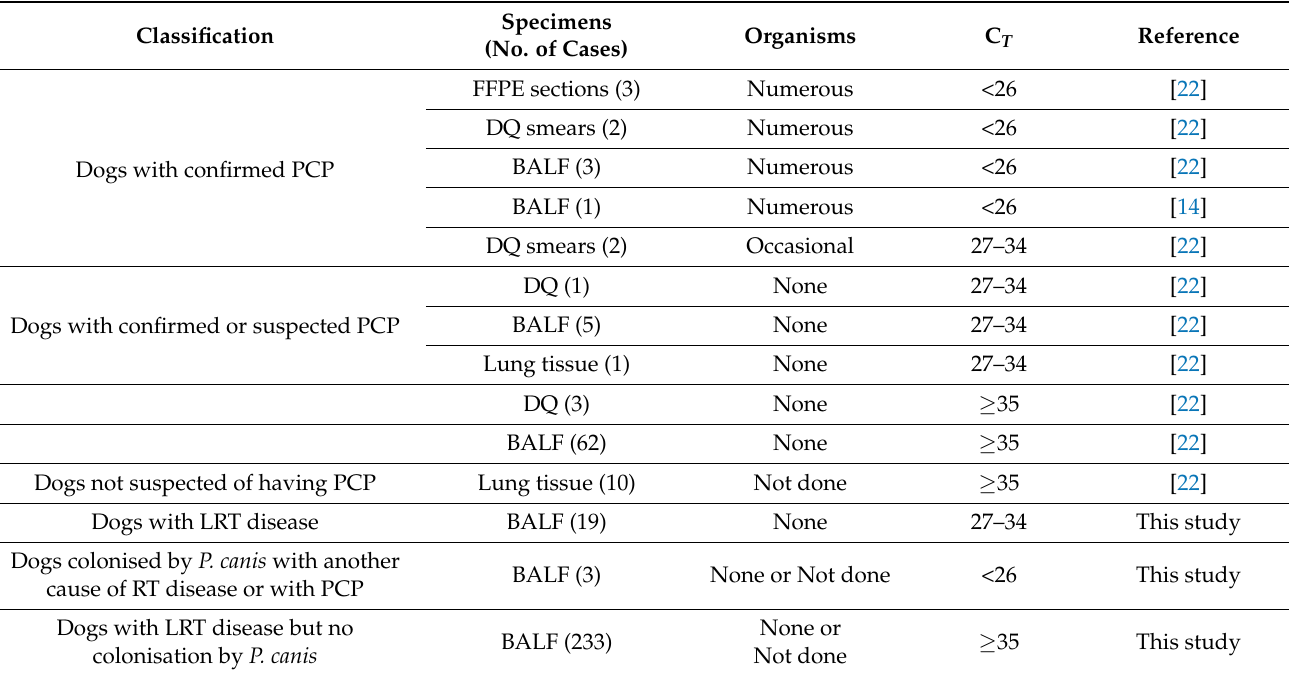
FFPE = formalin-fixed paraffin-embedded tissue; DQ = Diff-Quik